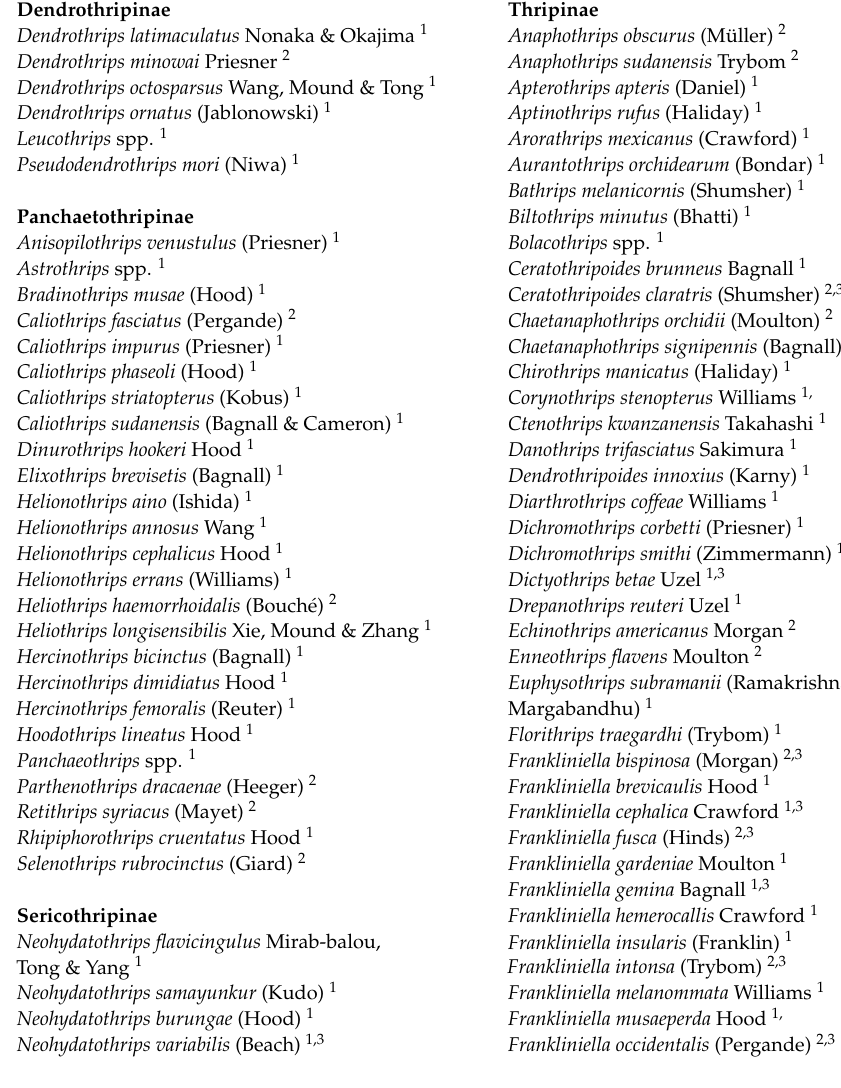
Table 1. Thripidae species (by subfamily) impacting on human crop productivity.